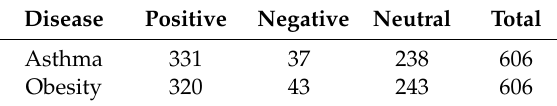
Table 2. Statistics of our gold standard